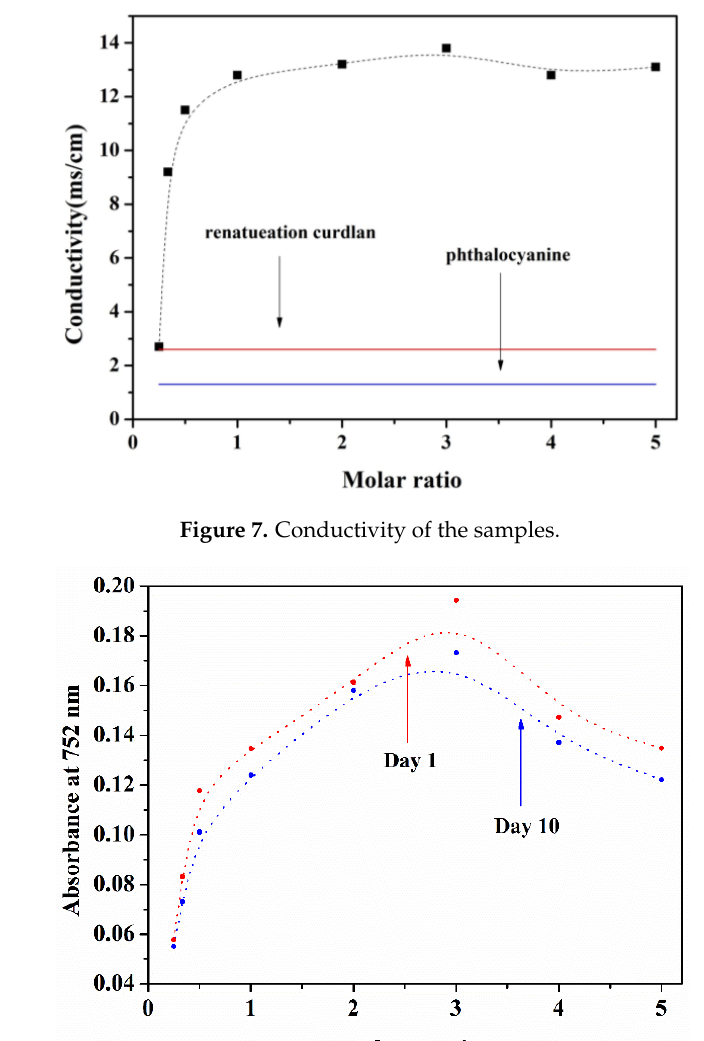
Figure 7. Conductivity of the samples.